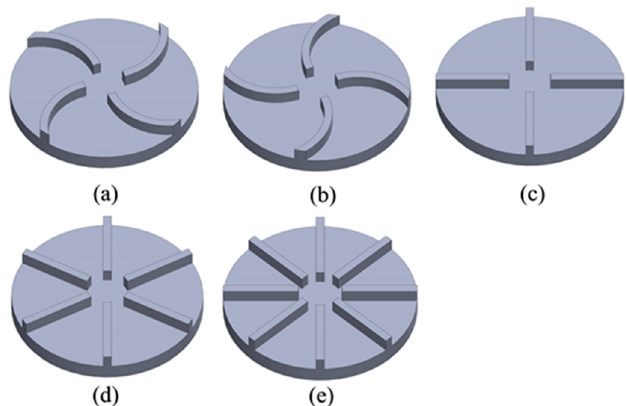
Figure 6. Schematic diagram of ( a ) 4 anti-clockwise covered vanes, ( b ) 4 clockwise covered vanes, ( c ) 4 straight vanes, ( d ) 6 straight vanes, and ( e ) 8 straight vanes. Table 3. Extraction efficiency under different bottom vanes. Bottom Vane Structure Liquid Holdup V m /mL Extraction Efficiency E O /% 4 anti-clockwise covered vanes,